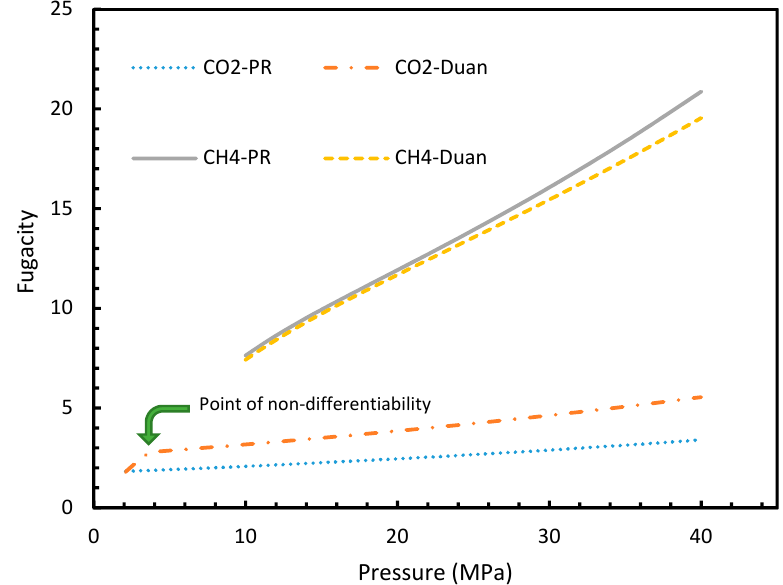
Figure 14. Comparison of Peng-Robinson (PR) and Duan fugacity in the case of CO 2 and CH 4. Similar to the situation in isothermal conditions, in isobaric conditions a point of non-differentiability was observed for Case 6. This resulted in higher rates of nucleation of CO 2 at high temperatures compared to CH 4 . At 30 MPa and 285 K, Case 6 produced a rate of nucleation of CO 2 of 3.67 × 10 7 , while for CH 4 the value was 4.25 × 10 − 23 and values for the other cases were